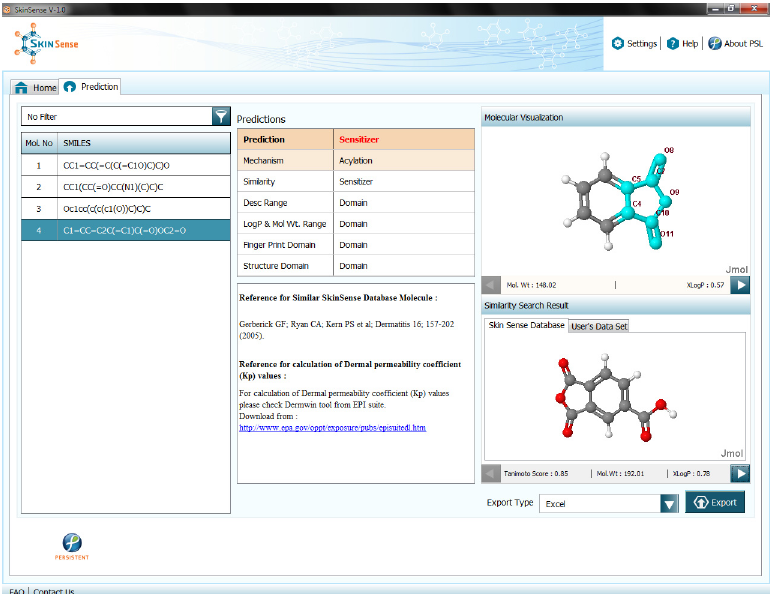
Fig 6. SkinSense – Result Screen. Table on the left shows SMILES of input molecules; ‘ Predictions ’ section shows prediction result for the selected molecule along with predicted reaction mechanism and domain information; ‘ Molecular Visualization ’ depicts the structure of selected molecule, along with skin protein reactive sub-structure(s) (if any) highlighted in cyan; ‘ Similarity Search Result ’ shows parent set molecules found similar to selected input molecule along with details such as Tanimoto coefficient; ‘ Export Type ’ offers various options to export SkinSense